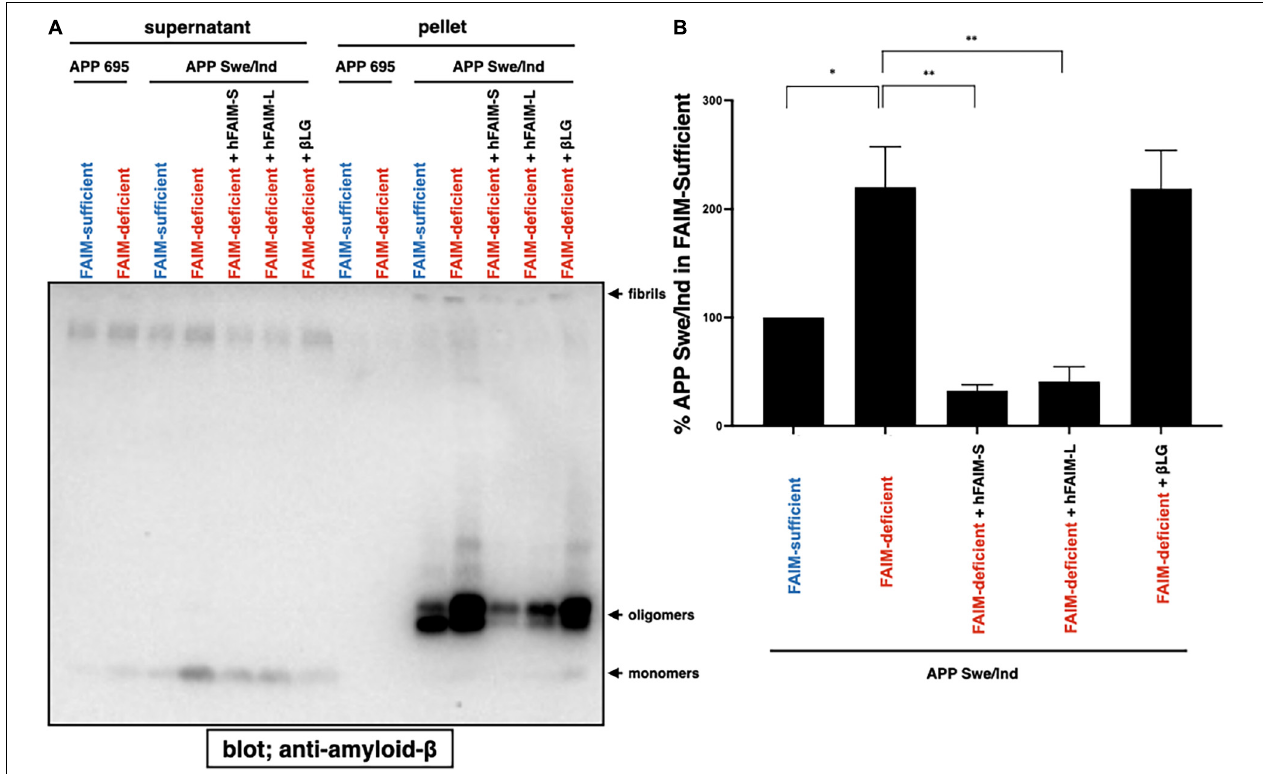
FIGURE 5 | Recombinant FAIM prevents A β fibrils in Neuro 2A cells. (A) WT and FAIM KO Neuro 2A cells were transiently transfected with expression vectors for APP695 and mutant APPswe/ind. One day later, 1 µ M hFAIM-S, hFAIM-L, or β LG were added into the cell culture. At day 4 after the transfection, culture supernatants were fractionated into soluble and insoluble-pellet fractions by centrifugation at 14,000 × g for 10 min. Pellets were washed twice with PBS. Proteins for each fraction were analyzed by western blotting for A β . Representative data from at least three independent experiments are shown. (B) The levels of detergent-insoluble aggregates in (A) were quantified by densitometry, and the data from three independent experiments are shown as percent of APP Swe/Ind in the FAIM-sufficent lane. The data are expressed as mean ± SEM. A two-tailed, unpaired Student’s t -test was used to calculate p -values. ∗ p < 0.05, ∗∗ p <